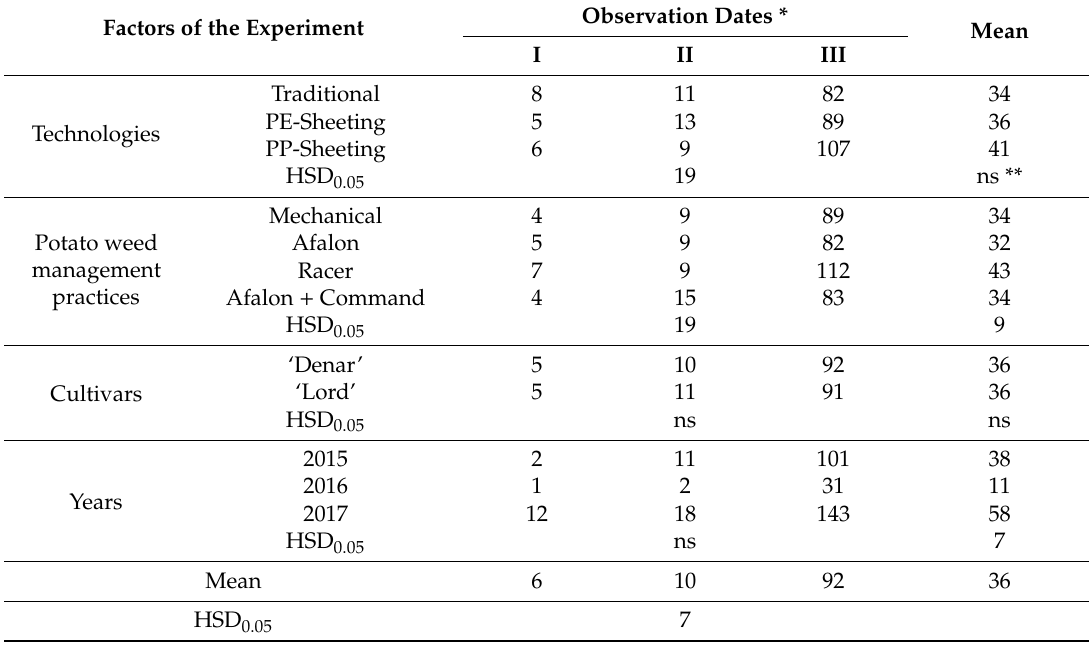
Table 8. Impact of cultivation technology, methods of weed management, cultivars, and years of cultivation on the air-dried mass of weeds (g. m − 2